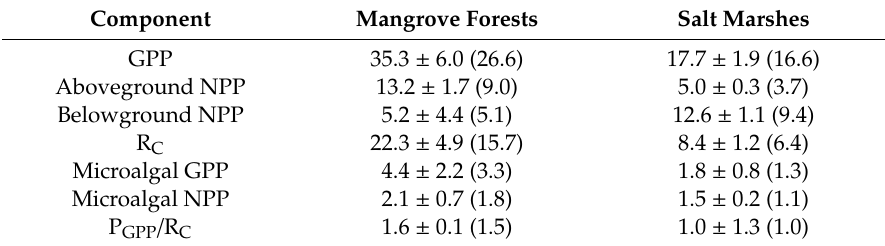
Table 2. Comparison of mean ( ± 1SE) GPP and above- and belowground net (NPP) primary production, canopy respiration (R C ) and benthic microalgal GPP and NPP between salt marsh and mangrove ecosystems. Units = MgC ORG ha − 1 a − 1 . Medianvaluesareinparentheses. Mangrovedatafrom[6,52,53]. Salt marsh g dry weight (DW) production converted to g C ORG using percent C ORG content in roots + rhizomes (41.5 ± 1.2%) and shoots (38.5 ± 0.7%) of various species (references in Table 1). Salt marsh